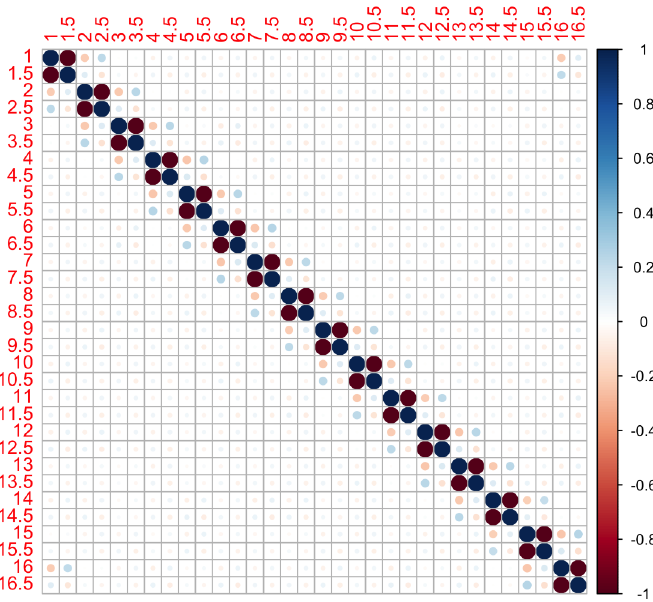
Figure 6 . Correlations among contributions to Im( S ) from integer and half-integer lattice sites. Positive correlations appear as blue dots and negative ones are depicted as red. The size of the dots represents the size of the correlation. There are small positive and negative correlations almost between all possible pairs, but the most dominant feature (other than the trivial unity correlation on the diagonal) is the strong negative correlation between the phase coming from integer lattice sites r and the half integers to their right, r +1 / 2 . The breaking of symmetry between left and right stems from the form of our ansatz (2.42), which, like the simple first order contour (2.15), includes only dependence of ψ on the value of the field to its right φ . These strong anti-correlations r r +1 are not enough for explaining the phase cancellations, since the size of the contributions at integer and half-integer values differs (recall figure 5). An added effect is the smaller negative correlations between two neighbouring half-integer sites, r +1 / 2 and r +3 / 2 , as well as between two neighbouring integer sites, r and r + 1 . This effect is stronger than the small positive correlations between sites r and r + 3 / 2 and between r and r − 1 / 2 , again, in light of the different size of contributions from integer and half-integer